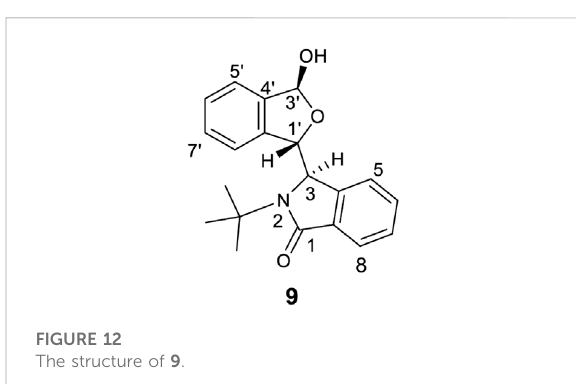
FIGURE 12 The structure of 9 .